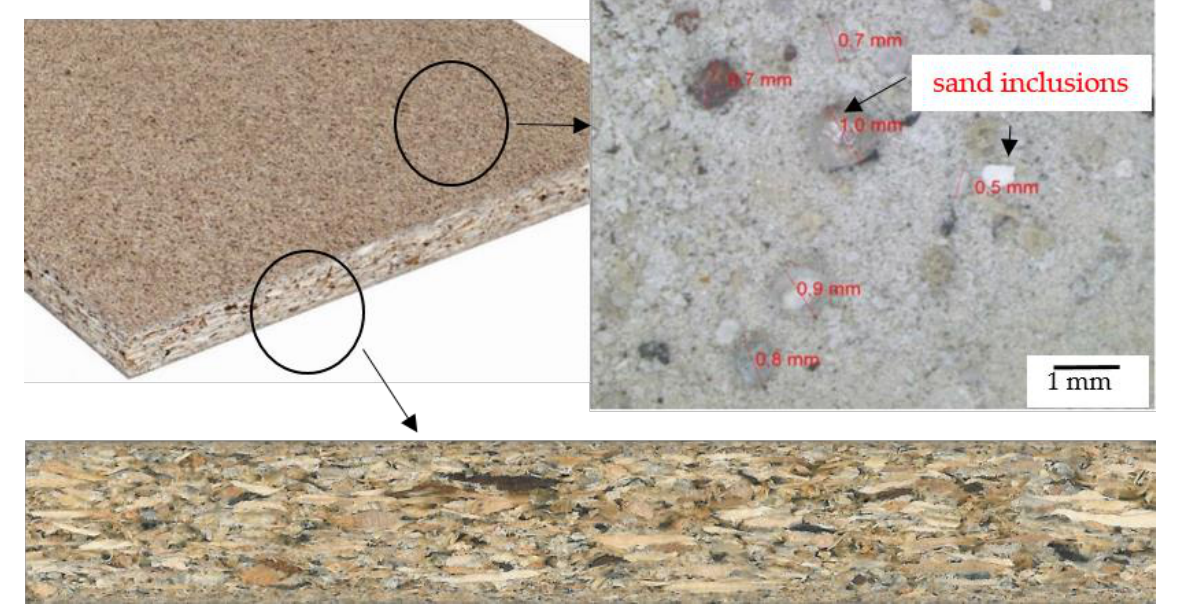
Table 1. Selected properties of the tested three-layer chipboard.